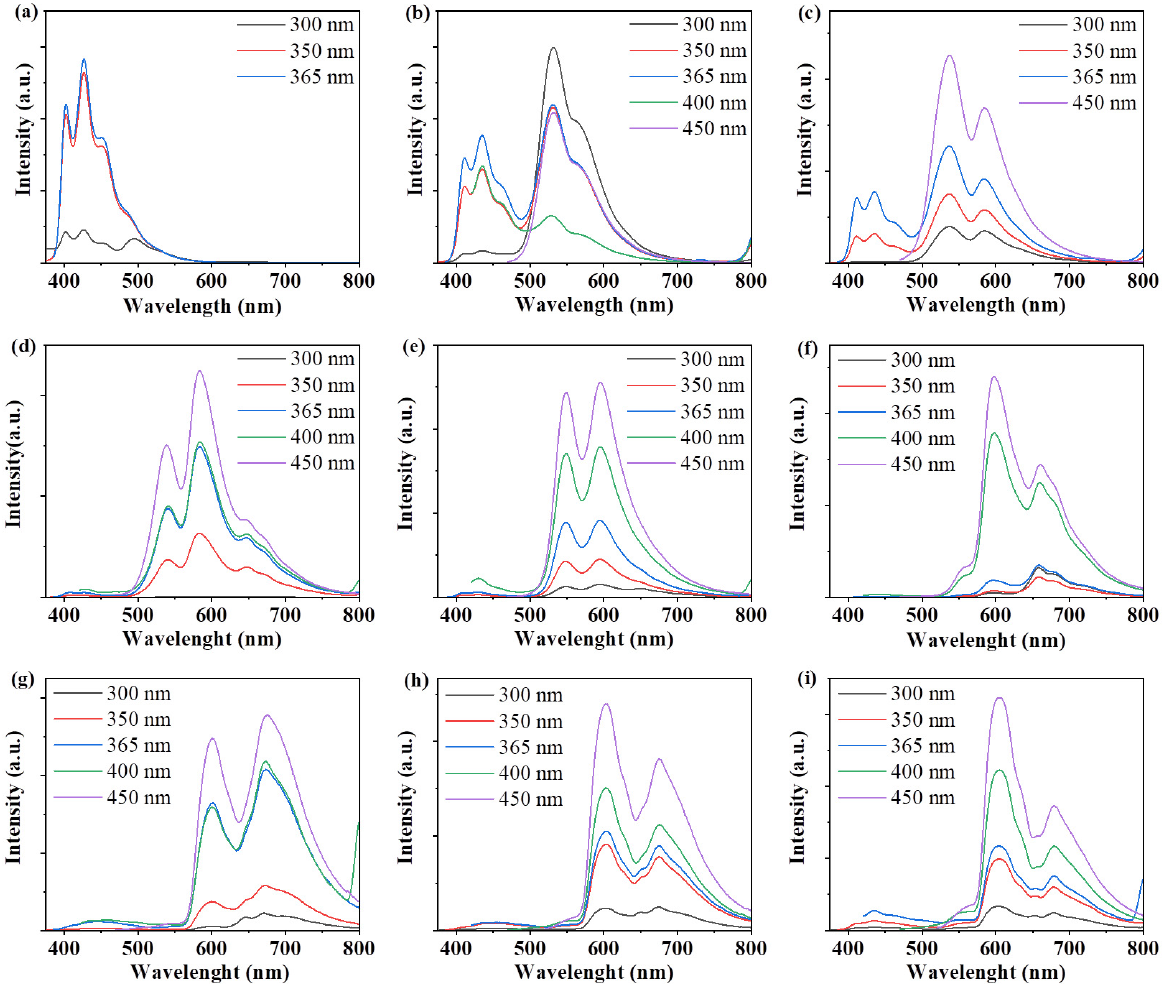
Figure 6. PL emission spectra of CDs-1 in ( a ) octane, ( b ) dichloromethane, ( c ) trichloromethane, ( d ) acetone, ( e ) tetrahydrofuran, ( f ) DMF, ( g ) methanol, ( h ) ethanol and ( i ) hexanol.